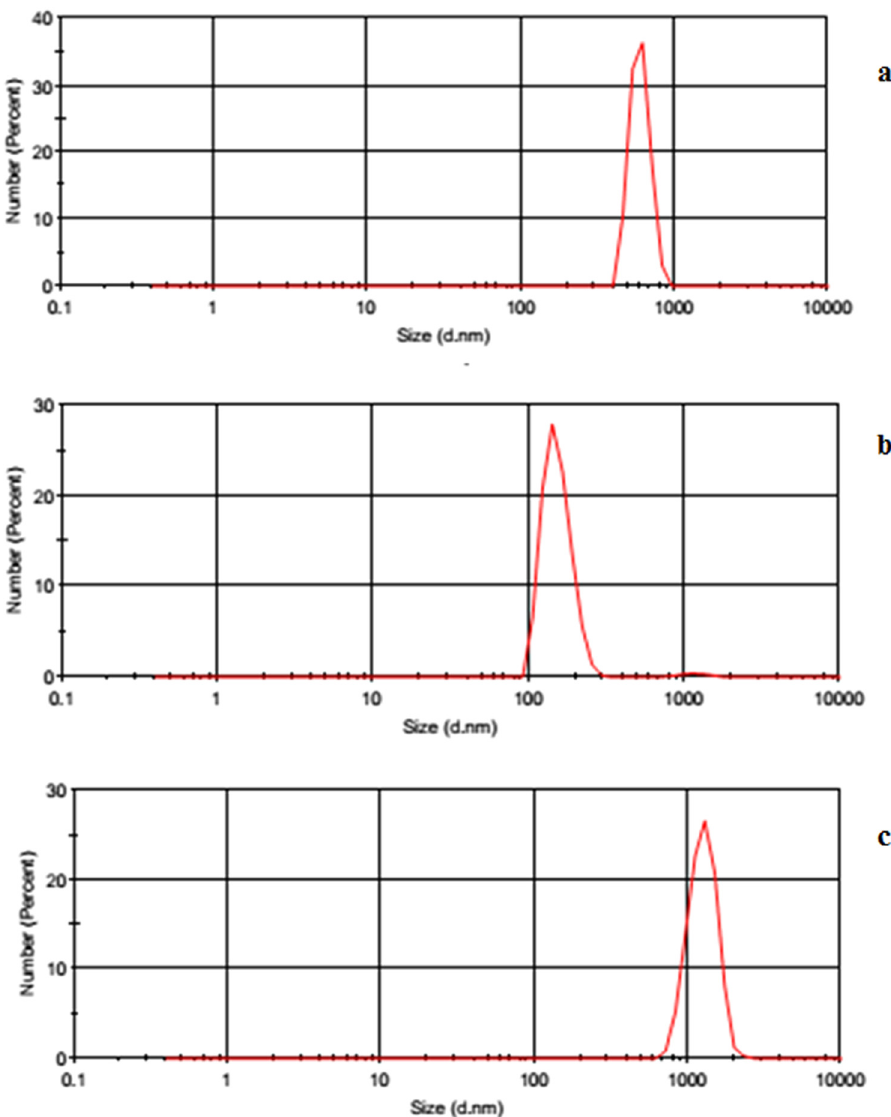
Figure 3: Particle size distribution of the synthesized Se NPs ( a ) , Ag NPs ( b ) and Au NPs ( c ) using co ff ee bean